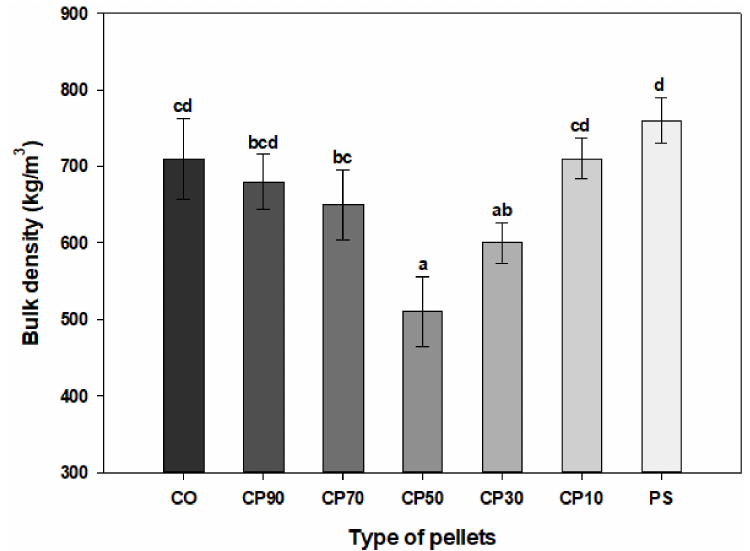
Figure 4. Bulk density of pellets according to SCG blending ratio. Each point is the mean of three repeated measurements and is the mean ± standard deviation. The means with different letters (a–d) above the bars indicate significant differences based on Tukey’s HSD test ( p < 0.05).